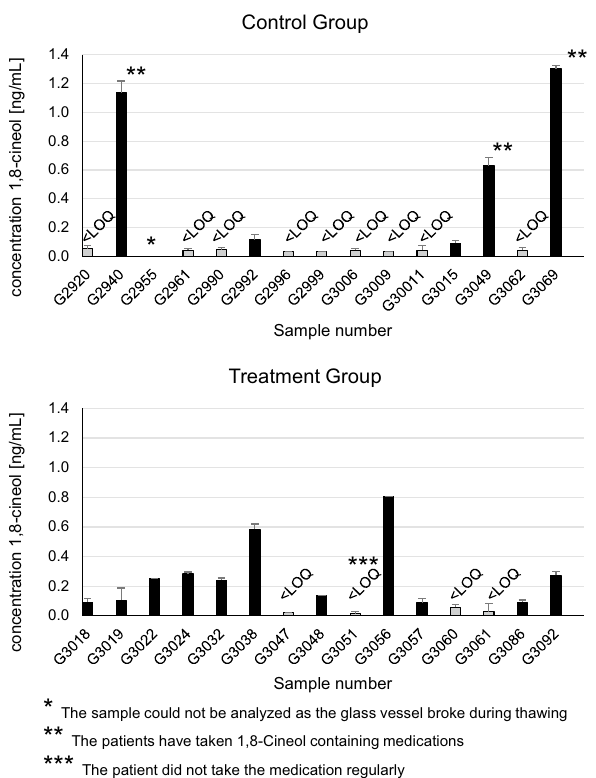
Figure 1. Concentrations of 1,8-Cineol in tissue extracts of nasal polyps from CRSwNP patients after 14 days of oral 1,8-Cineol administration. Results are shown as mean values of triplicates and confidence intervals. Concentrations below LOQ were set to ½*LOQ (gray bars). Concentrations above LOQ are shown as black bars. Sample G3024 was measured in duplicate only as the PDMS twister